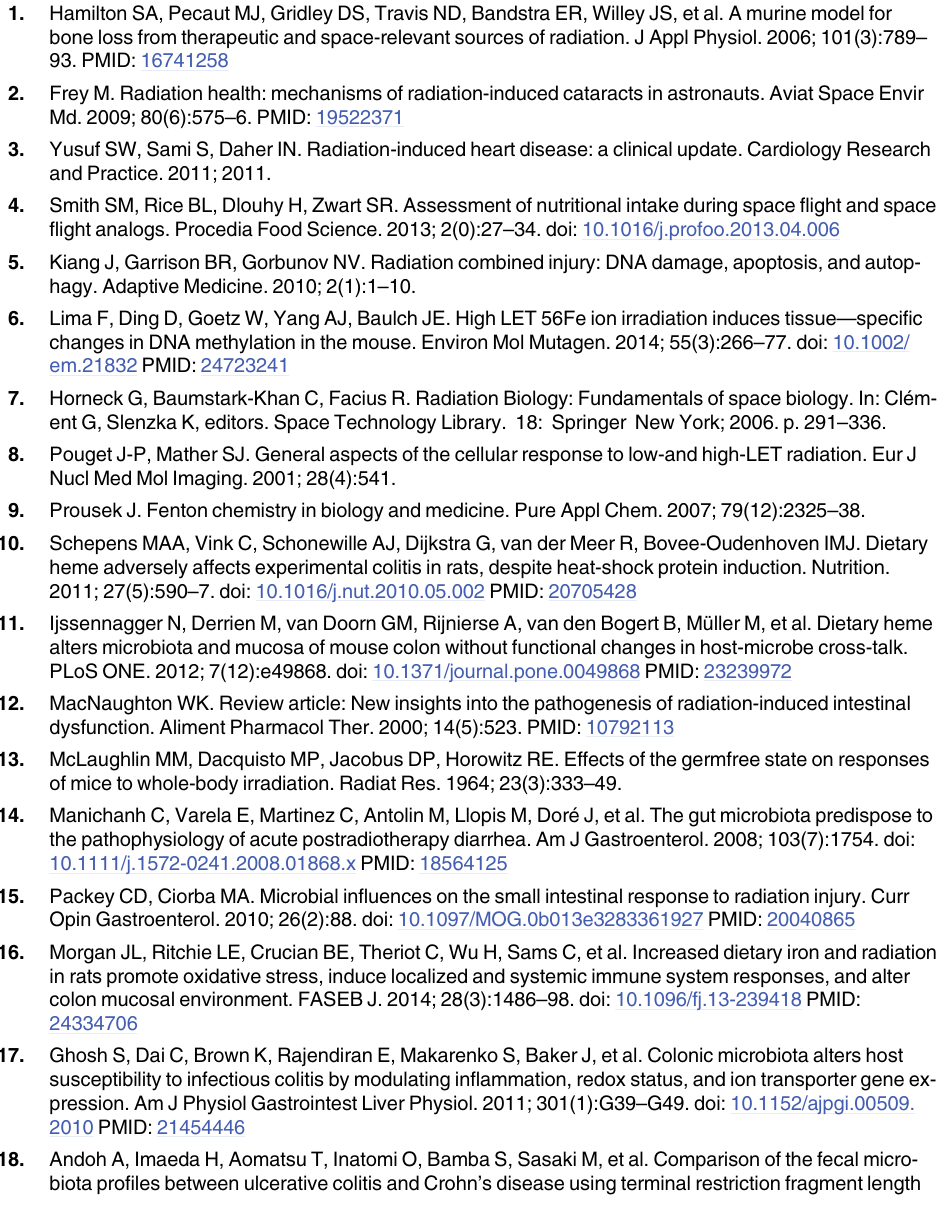
S4 Table. Relative abundance (%) of bacterial taxa in feces of mice resulting from 13 days spaceflight (Experiment 3).